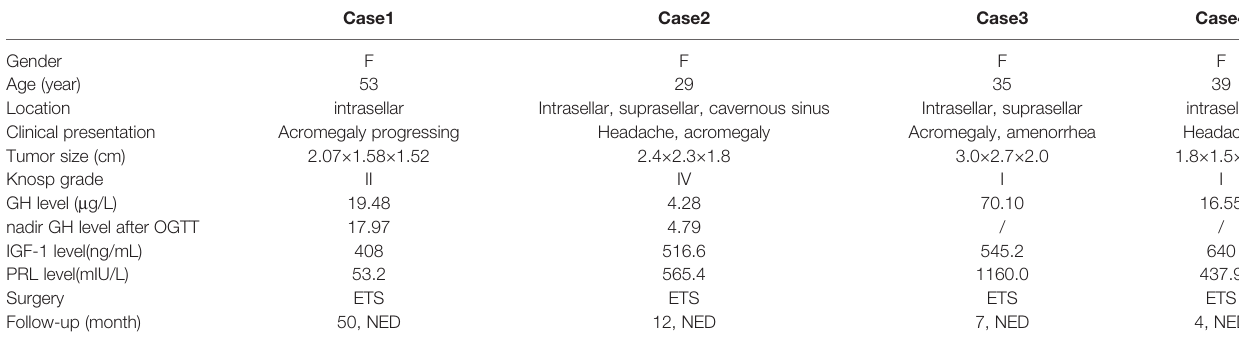
TABLE 1 | List of clinical characteristics of the